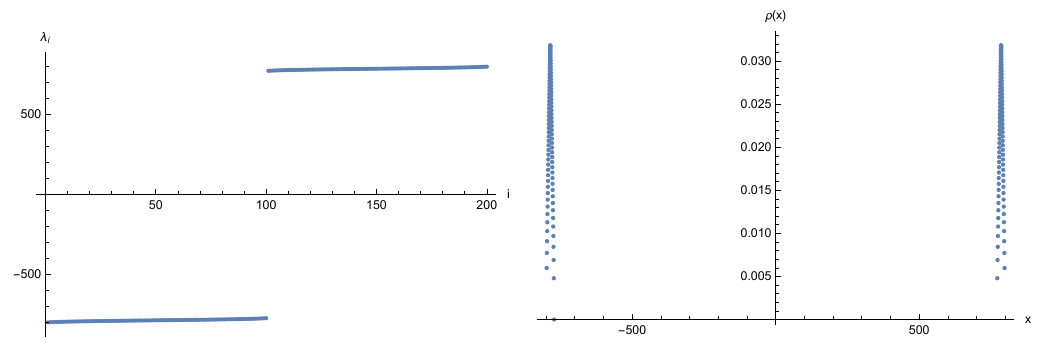
Figure 4 . The left (cid:12)gure shows the solution of the saddle point equation of (D.1) with ( N; N f ; m ) = (200 ; 2 ; 500). The horizontal line means the label of the eigenvalues. The right one shows that the density of the eigenvalues with the same parameter. The horizontal line means the degree of the